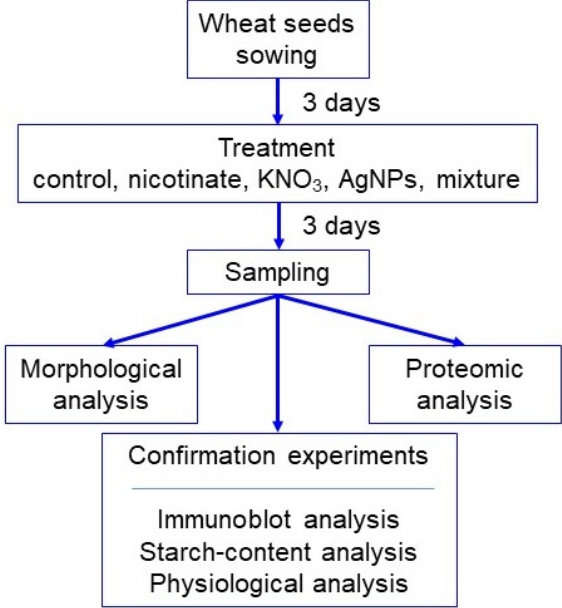
Figure 1. Experimental design for morphological, proteomic, and confirmation analyses of wheat treated with the mixture of AgNPs, nicotinate, and KNO 3 . Three-day-old wheat seedlings were treated with and without 8 mM nicotinate, 0.1 mM KNO 3 , 5 ppm AgNPs, and 5 ppm AgNPs/8 mM nicotinate/0.1 mM KNO 3 (mixture) for 3 days. Wheat seedlings were analyzed with morphology and proteomics. Proteomic results were confirmed by immunoblot, starch-content, and morphophysiological analyses. All experiments were performed with 3 independent biological replicates.